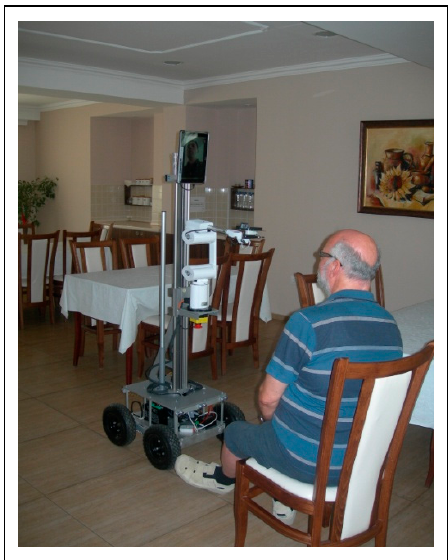
Figure 7. Experimental environment.